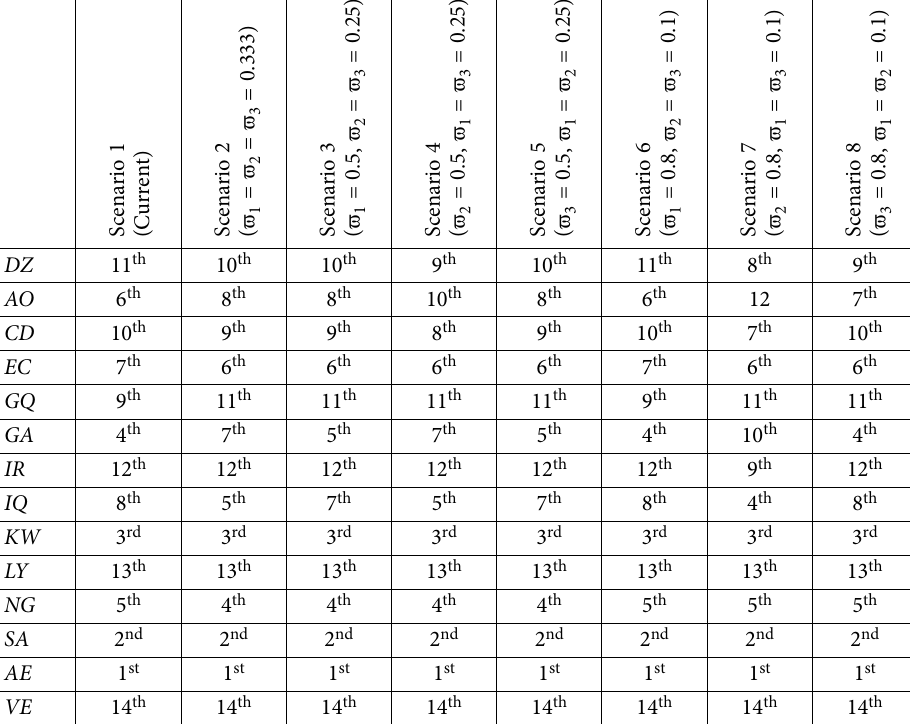
Table 9. The ranking order of alternatives as per the changes of the weights of CCM, UCM, and ICM